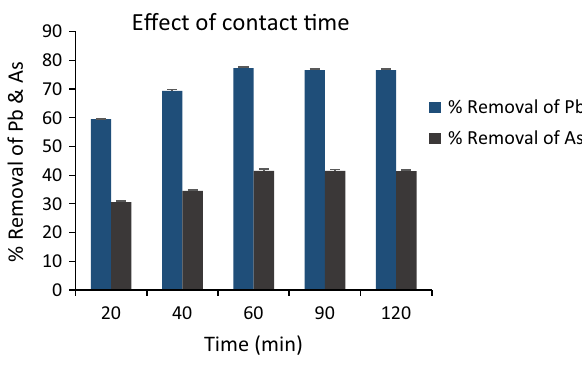
Fig. 8 Effect of contact time on adsorption of Pb and As. Experimen- tal conditions: adsorbent dose 3 g/100 ml, temperature 37 °C and pH 4.0 (Pb) and 2.0 (As). Values are mean ± SE, n =